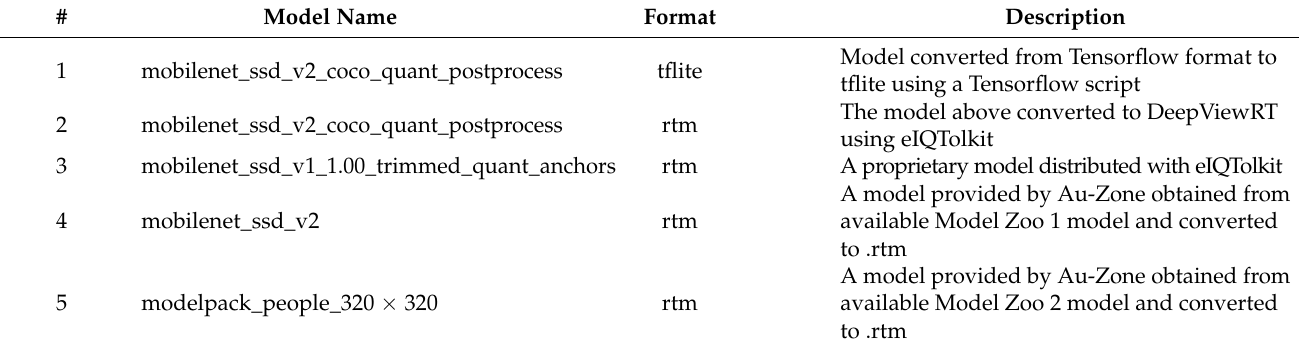
Table 1. Models used for inference tests of the Tekniker AI Embedded